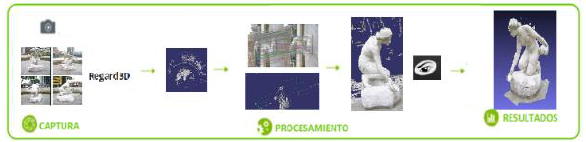
Figure 4. La Rebeca monument workflow.